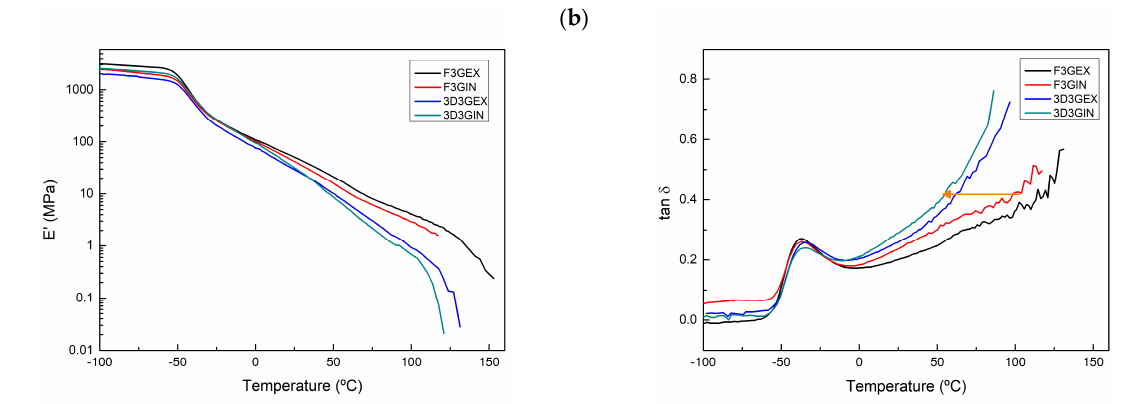
Figure 11. ( a ) Storage modulus and ( b ) tan δ curves of 3D printed specimens.